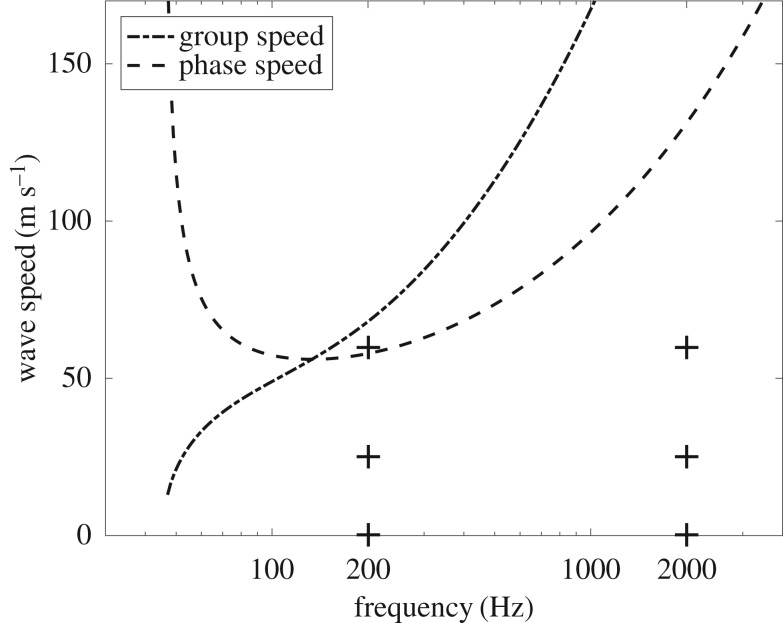
Circumferential phase speed and group speed in tyre versus frequency (logarithmic scale). The crosses indicate the frequency (200 and 2000 Hz) and moving speeds (V = 0 km h−1, V = 90 km h−1 and V = 216 km h−1) of figures 3–6.